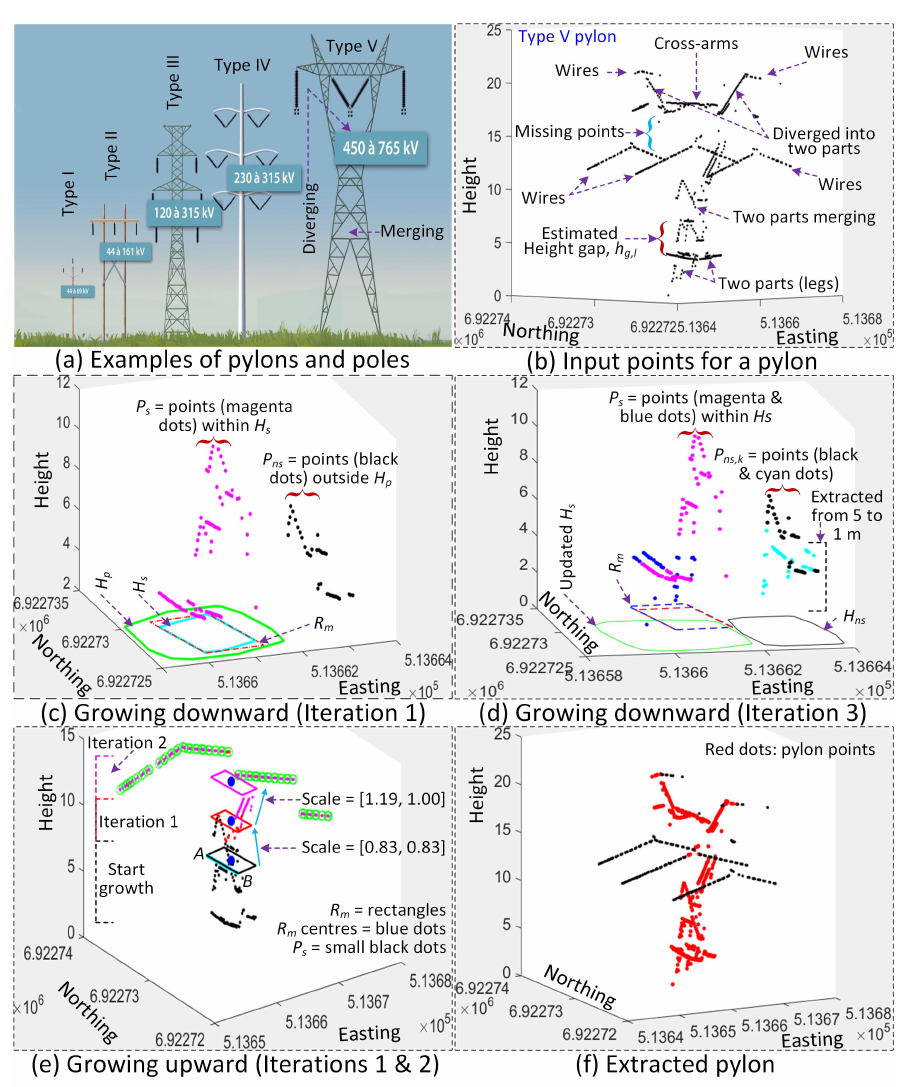
Figure 8. Extraction of a pylon. Easting, Northing and Height are in metres (m). H p , pylon hull; H s , seed hull; H ns , non-seed hull; and R m , the minimum bounding